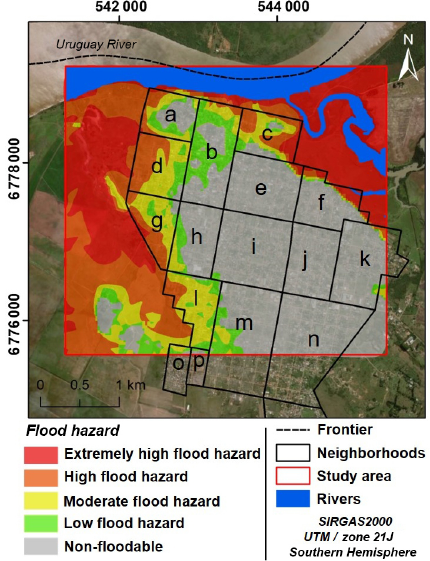
Figure 8. Flood hazard map of Itaqui, Rio Grande do Sul,